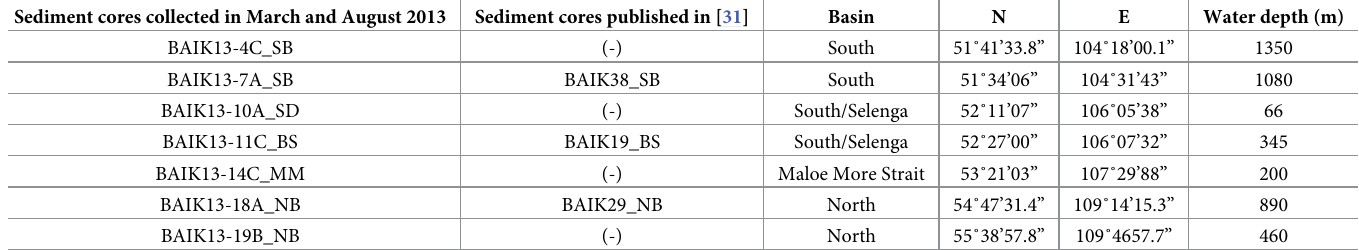
Table 1. Location of both the sediment cores collected in March and August 2013 and the published diatom records at nearby coring sites in Lake Baikal collected in 1993/1994 [31]. Water depths at each coring site are shown, along with the location which they were collected from. [SB: South basin, BS: Buguldieka Saddle; SD: Sel- enga Delta, MM: Maloe More and NB: North